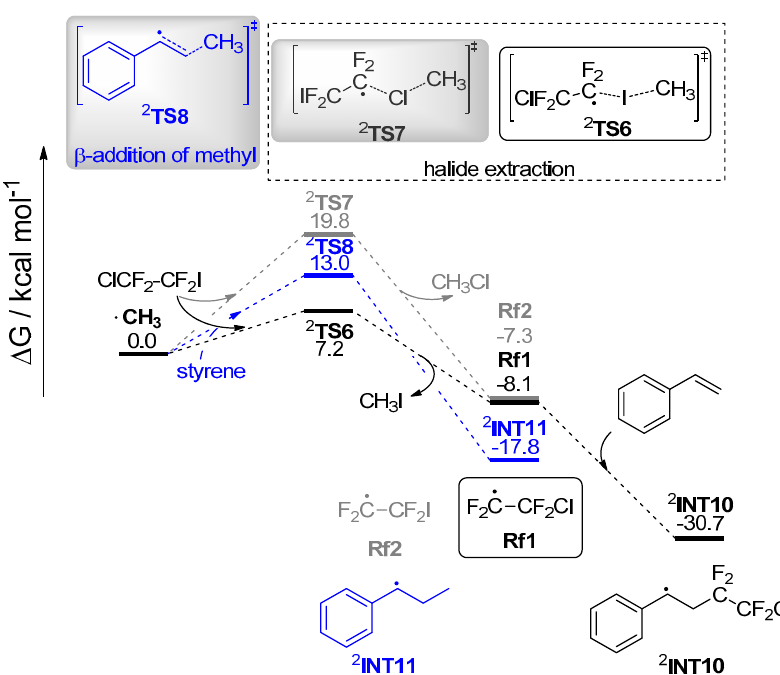
Figure 3. The Gibbs free energy profile for the benzyl radical generation from methyl radical via radical relay pathway. Relative free energies are in kcal/mol.